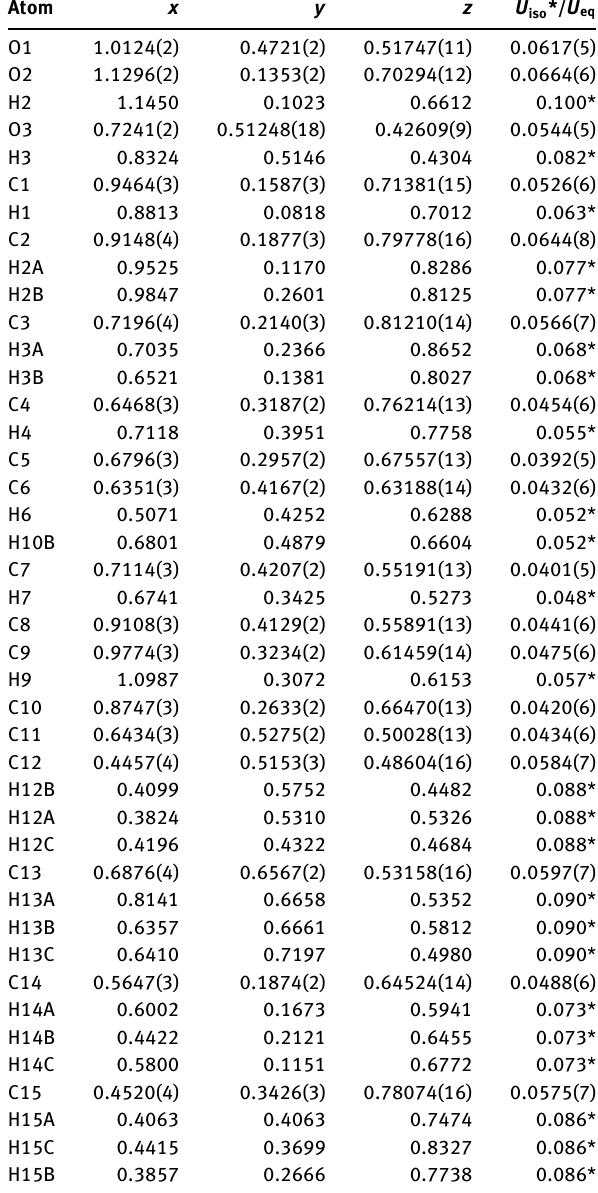
Table 2: Fractional atomic coordinates and isotropic or equivalent isotropic displacement parameters (Å 2